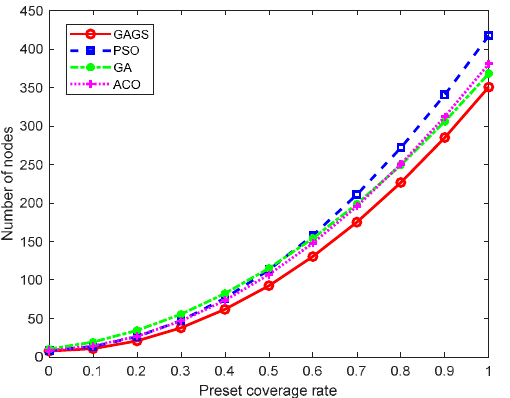
Figure 15. Line chart of algorithm coverage ratio comparison under preset coverage ratio.